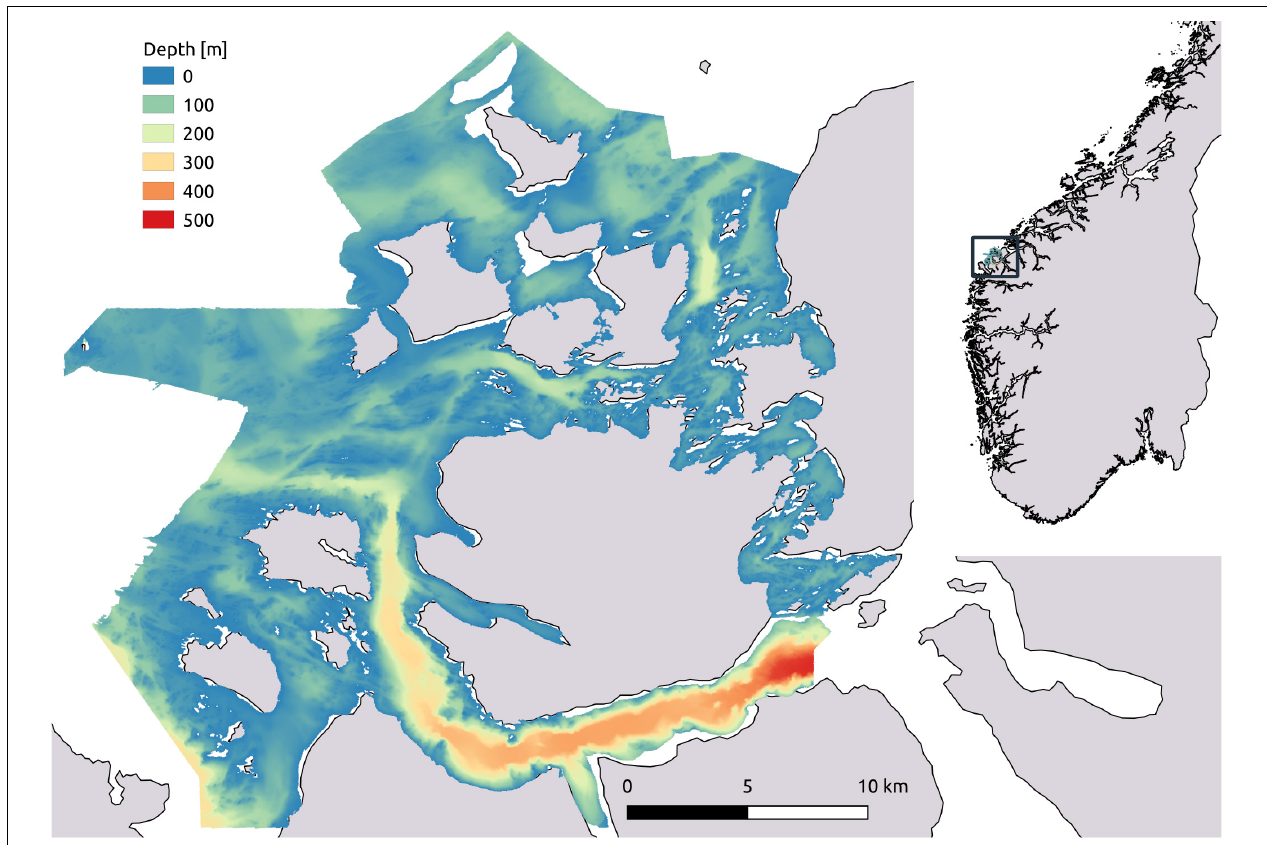
FIGURE 1 | Map showing the geographical location and the extent of the study area as outlined by the bathymetry raster. The observations as well as the spatial predictions are limited to depths shallower than 35